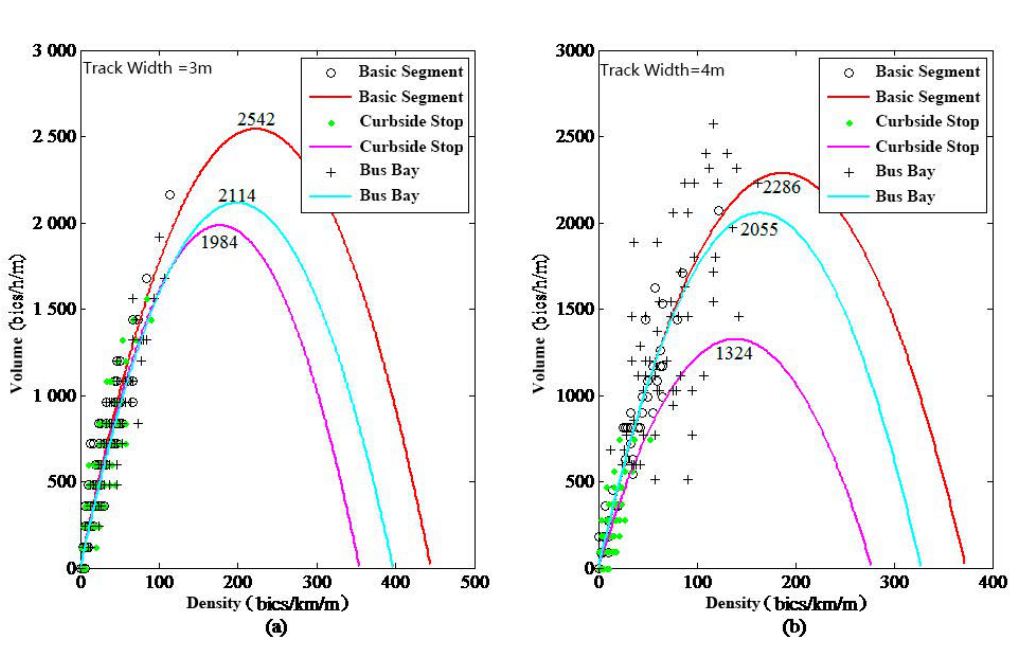
Figure 5. Fitting Results of Capacities Track of ( a ) 3 m and ( b ) 4 m wide at Basic Segment, Curbside Stop, and Bus Bay.